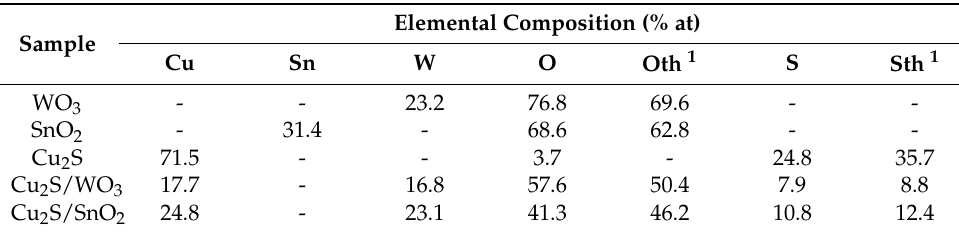
Table 2. Average surface atomic composition of the photocatalysts by energy-dispersive X-ray spectroscopy